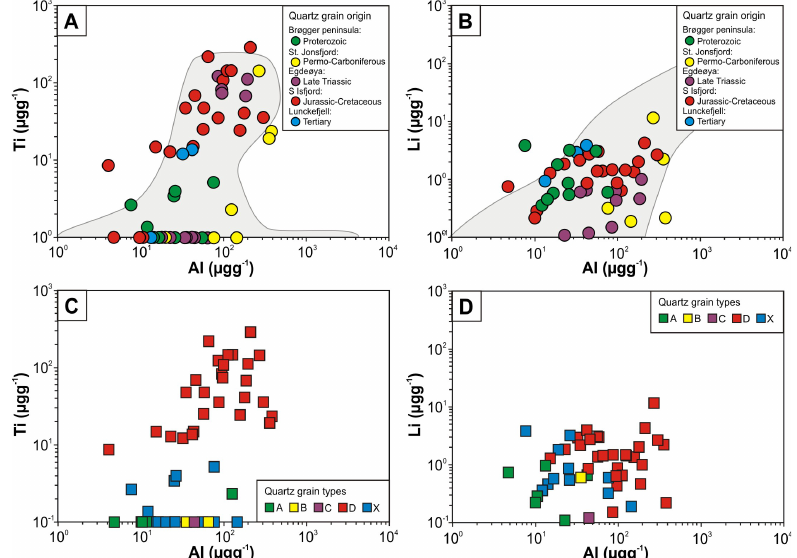
Fig. 9. Concentrations of Al versus Ti and Li of quartz grains in onshore samples. The same data are plotted, first, with respect to sample origin (A, B) and, second, to quartz type (C, D) . In general, the concentrations plot in the same range as the offshore samples (grey shaded areas). (A, B) Samples from southern Isfjord are characterized by high Ti due to high proportion of D type grains (see C ). (C, D) Type D grains have distinctively high Ti and relatively high average Al compared to the grain types A, B, C, and X. X type samples are quartz types which were not found in the offshore